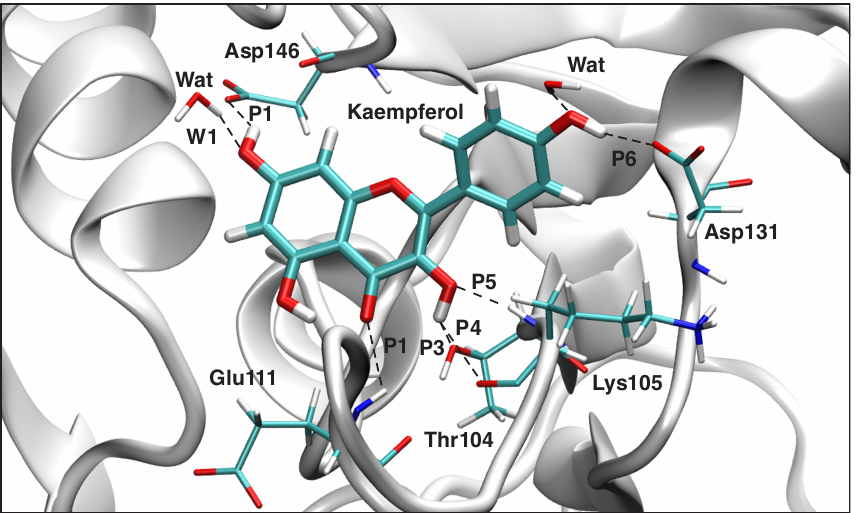
Figure 12. Optimized geometry of the Kaempferol-NS5 complex. The QM part includes Kaempferol, indicated by bold sticks; the MM part includes the NS5 protein, water molecules, and counter ions (for further details, see Supporting Information). There are ten hydrogen bonds (dashed lines) between Kaempferol and the Asp146, Asp131, Lys105, Thr104, and Glu111 residues (thin sticks) of NS5 between Kaempferaol and the two water molecules and two intramolecular hydrogen bonds; see also Figure 11. (Number of QM atoms: 31, total number of atoms: 14,337). ω B97X-D/6-31G(d,p)/AMBER level of